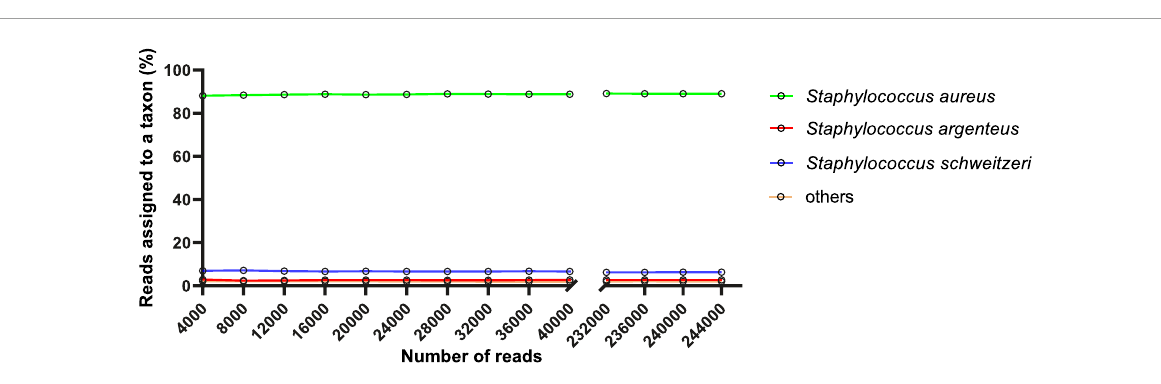
FIGURE5 A representative of BLAST analyses for taxon assigned reads. Data was obtained following DNA sequencing for DNA isolated using the Mol Com5 cent − nuc approach (one of the